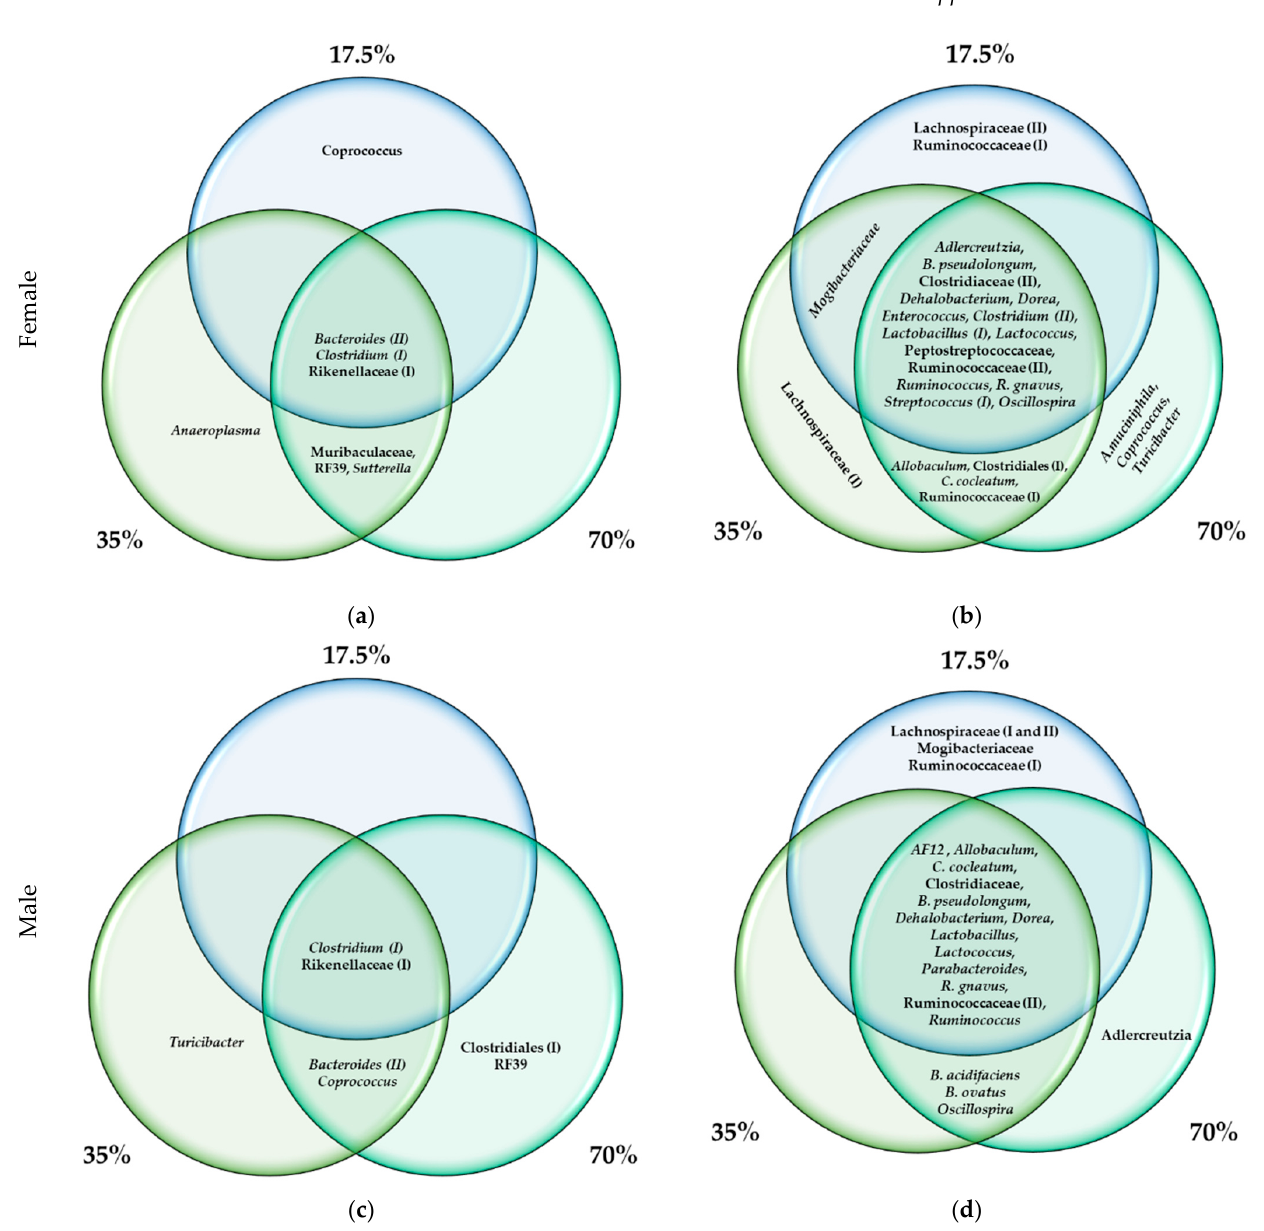
Figure 6. Bean-induced bacterial biomarkers of the ( a , c ) female and ( b , d ) male cohorts according to the pairwise linear discriminant analysis (LDA) of effect size (LEfSe) at the feature level. Panels ( a , b ) exhibit bean-enhanced, whereas ( c , d ) exhibit bean-suppressed bacterial biomarkers. All represented bacteria were statistically significant (LDA score > |2.0|, FDR-adjusted p -value <